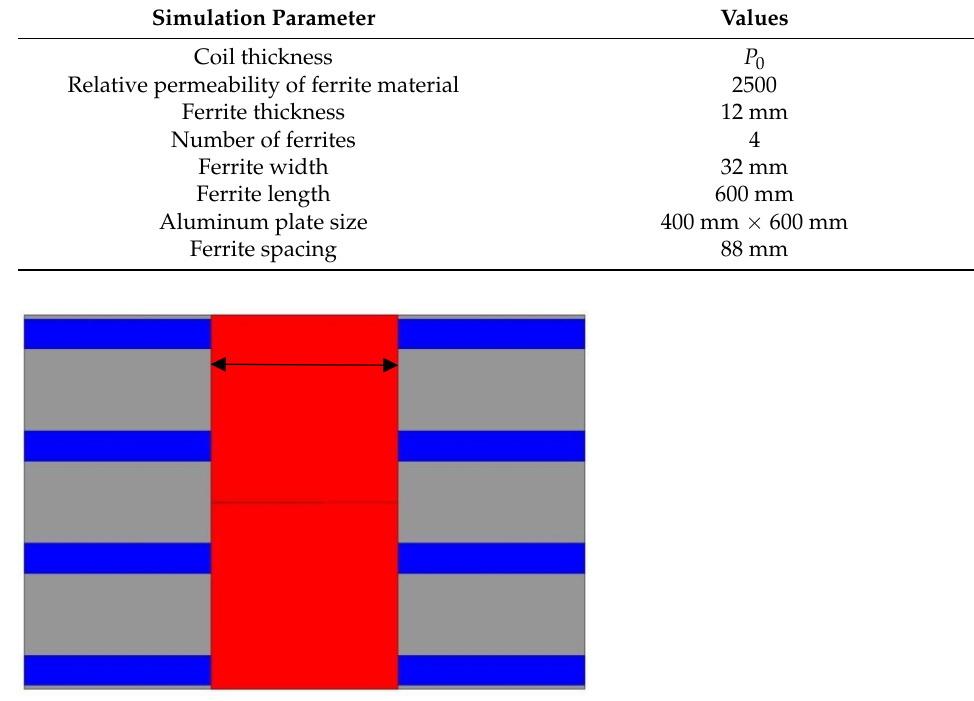
Figure 18. Schematic diagram of key geometric parameters of the solenoid-structure